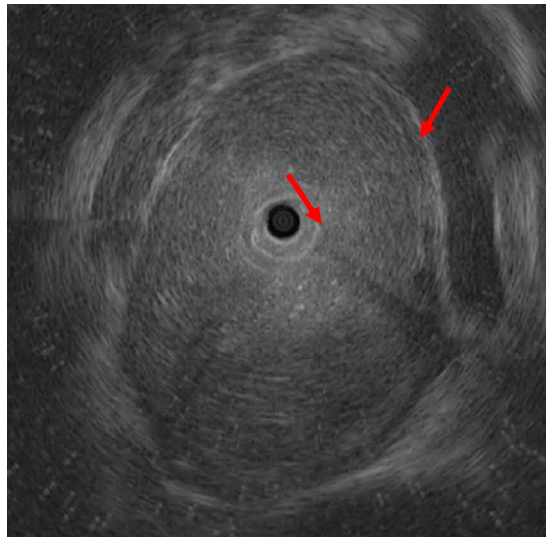
Figure 7. A 76-year-old woman with acute phlegmonous esophagitis. Endoscopic ultrasonographic image shows diffuse hypoechoic lesion (arrows) at the submucosal and inner muscularis layers of the esophagus.